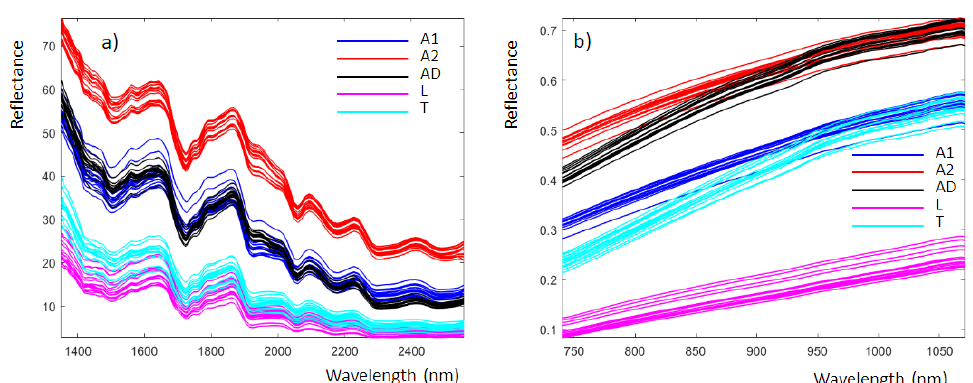
Figure 2. Insect powder recorded using ( a ) the NeoSpectra MDK and ( b ) the SCiO, colored according to the different classes previously defined.